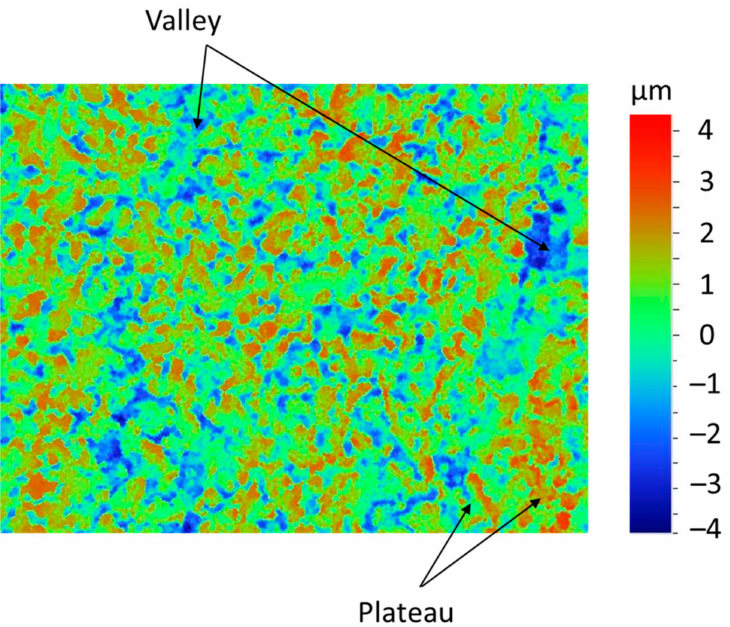
Figure 1. Surface profile for bare HDG steel after solvent cleaning obtained by optical profiler (1.2 × 0.9 mm 2 ).